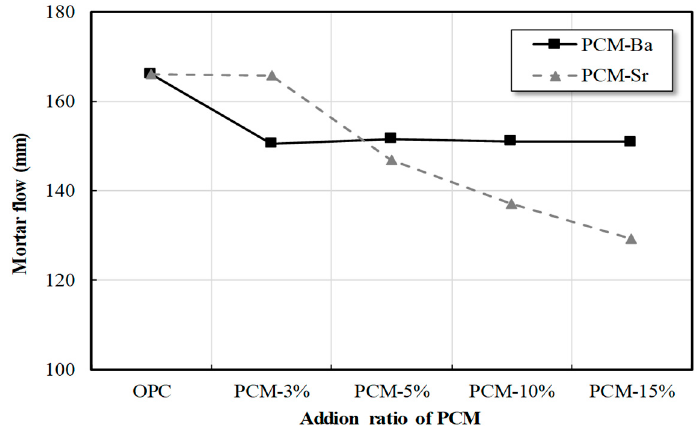
Figure 7. Effects of addition mix ratio of PCM on cement mortar flow.